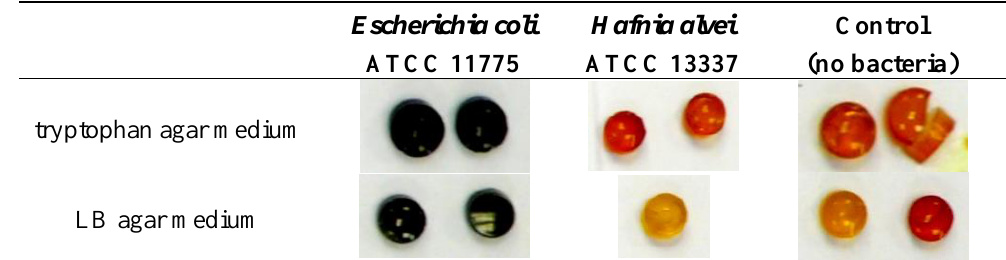
Table 1. Coloration of the sensors after 24 h: dark green for E. coli (indole-positive) and dark orange for the two control tests: H. alvei (indole-negative) and blank sample